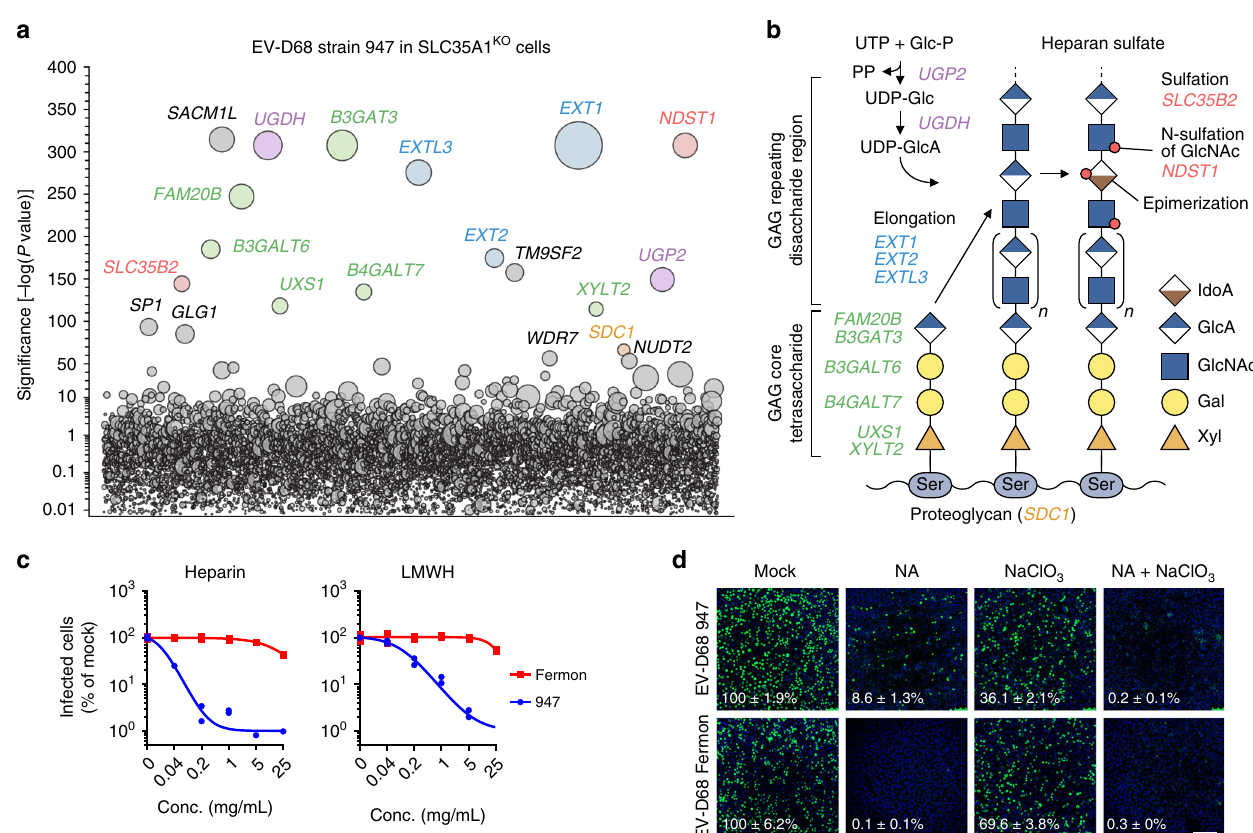
Fig. 1 Both sialic acid and sulfated glycosaminoglycans can serve as EV-D68-947 receptors. a Haploid genetic screen for host factors of EV-D68-947. Each circle represents a gene, with size corresponding to the number of genetrap insertions per gene. The y -axis indicates the signi fi cance of enrichment of insertions in a gene, compared to an uninfected control population. Genes were randomly distributed on the x -axis. b Schematic overview of sulfated glycosaminoglycan (sGAG) synthesis, showing the functions of genes identi fi ed in the haploid screen, which are indicated in italics. UTP, uridine-5- triphosphate; UDP, uridine diphosphate; P, phosphate; Glc, glucose; GlcA, glucuronic acid; IdoA, iduronic acid; GlcNAc, N-acetylglucosamine; Gal, galactose; Xyl, xylose. c EV-D68 strains were incubated with various concentrations of heparin or low-molecular-weight-heparin (LMWH), followed by infection of HeLa-R19 cells, dsRNA staining and quanti fi cation of infected cells. Two technical replicates are shown. d HeLa-R19 cells were treated with neuraminidase (NA), sodium chlorate (NaClO 3 ) or a combination of both and infected with EV-D68, followed by staining of dsRNA (green) and nuclei (blue). Shown are representative confocal micrographs. Values denote the number of infected cells (mean ± s.e.m. of 3 – 4 technical replicates) as percentage of mock. Scale bar: 150 µ m. The experiment was conducted three times with similar